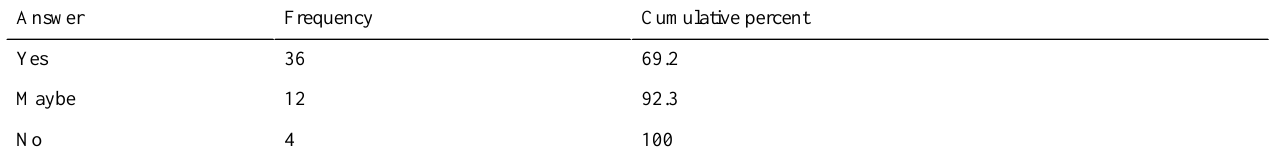
Table 7. Students’answers to the question: “Would you use this simulation as a teaching tool if you were an instructor?” (n=52).